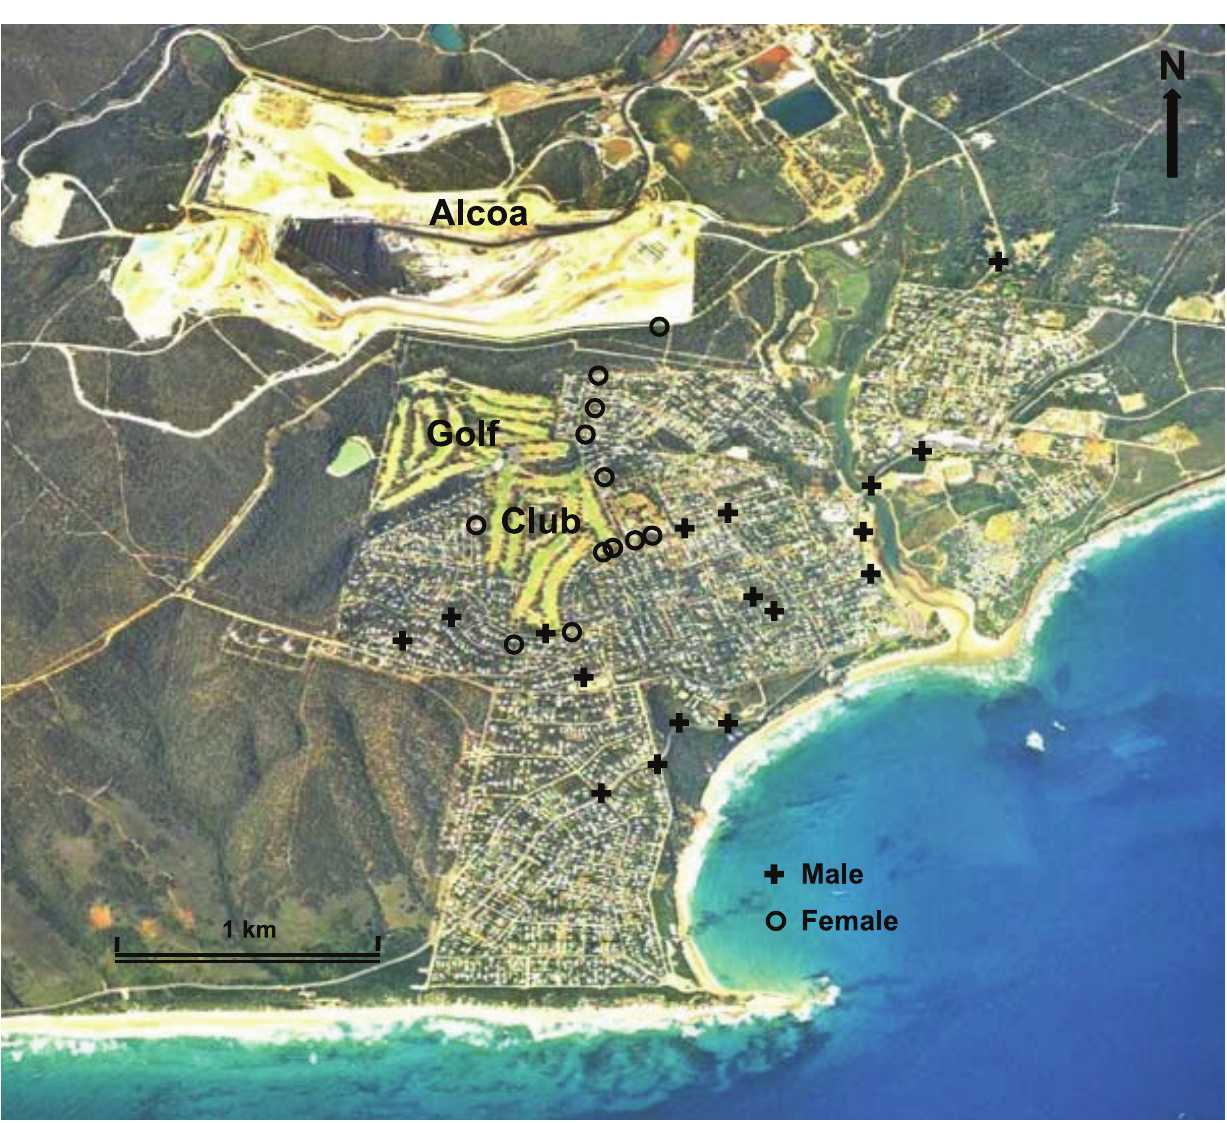
Figure 1. Aerial photograph of Anglesea, Victoria, Australia, showing the compact residential area bounded by the Anglesea Heath, the Anglesea Golf Club (Golf) within the town boundary, and the Alcoa Australia coal mine and power station (Alcoa) to the north of the town. Also shows locations of road-kills of tagged male and female Eastern Grey Kangaroos Macropus giganteus reported from 2008 to